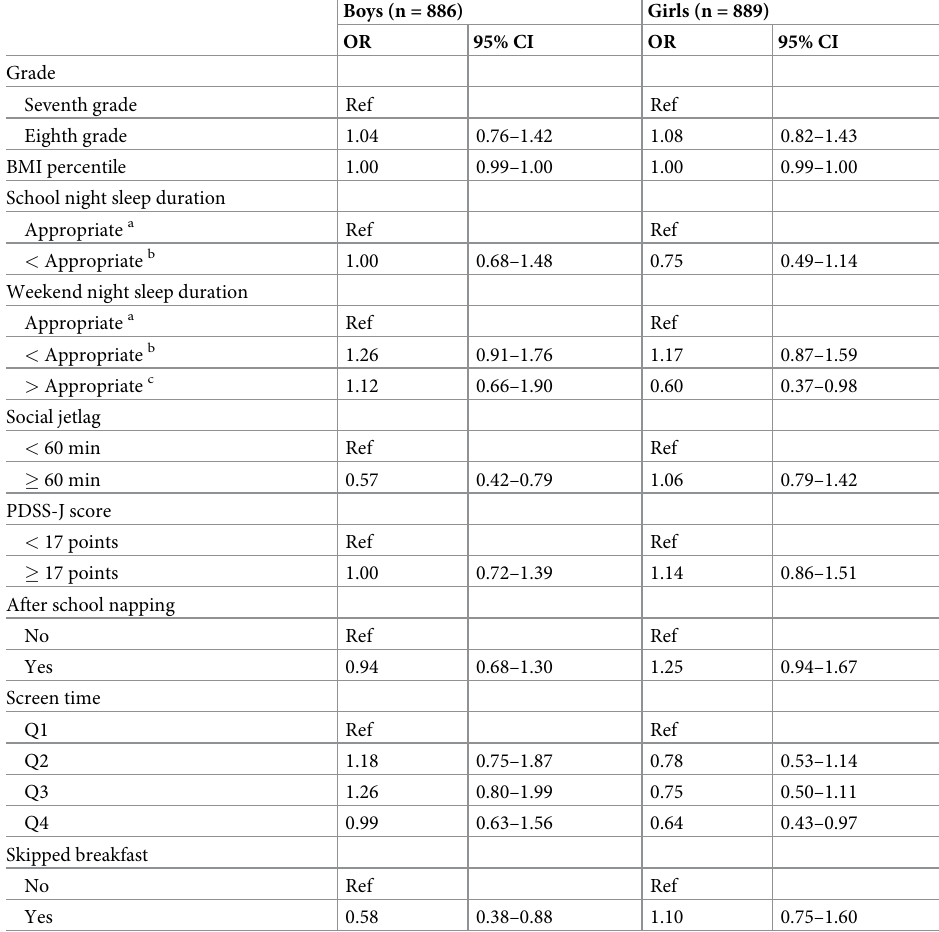
Table 3. Sleep habits relating to physical activity in junior high school students (seventh and eighth